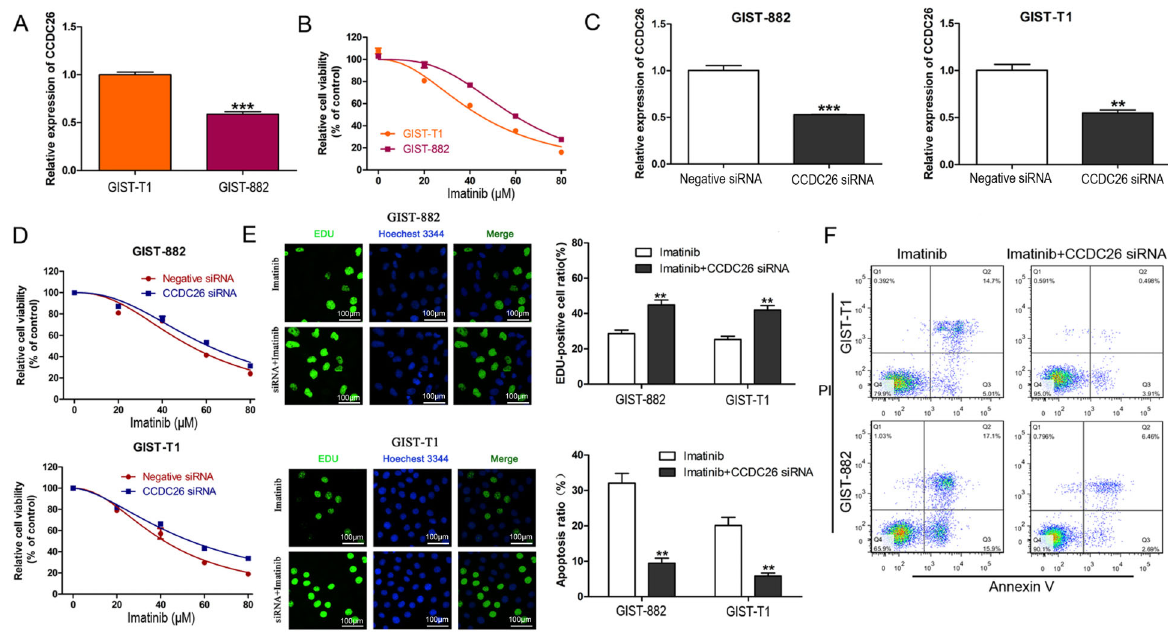
Figure 3. Knockdown of CCDC26 induced imatinib resistance in gastrointestinal stromal tumors (GIST) cells. A , Expression of CCDC26 in GIST-T1 and GIST-882 cells by real time PCR. ***P o 0.001 vs GIST-T1. B , Cell viability of GIST-T1 and GIST-882 cells in the presence of different concentrations of imatinib by CCK-8 assay. C , The interfering ef fi ciency validation of CCDC26 siRNA by real time PCR. **P o 0.01, ***P o 0.001 vs Negative siRNA (Student ’ s t -test). D , CCK-8 assays were performed to determine the cell viability of GIST-T1 and GIST-882 cells treated with CCDC26 siRNA or control siRNA in the presence of different concentrations of imatinib. E , EDU assay was employed to examine cell proliferation in GIST-T1 and GIST-882 cells cultured with imatinib (GIST-T1, 41.97 m M; GIST-882, 56.90 m M) and treated with CCDC26 or control siRNA ( (cid:2) 200 magni fi cation; bars: 100 m M). The number of EDU positive cells was counted. **P o 0.01 vs imatinib (Student ’ s t -test (parametric); Mann-Whitney test (non-parametric)). F , Flow cytometric analysis of apoptotic GIST-T1 and GIST-882 cells transfected with control or CCDC26 siRNA and treated with imatinib for 48 h, **P o 0.01 vs imatinib (Student ’ s t -test (parametric); Mann-Whitney test